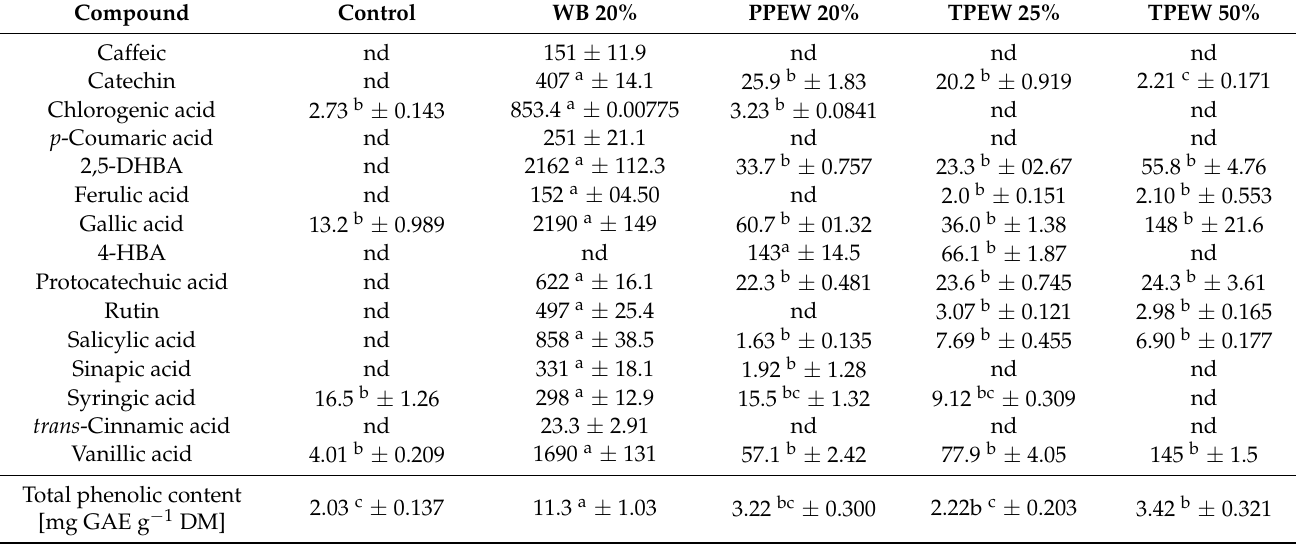
Table 3. Content of phenolic compounds ( µ g g − 1 DM) in fruit bodies of Pleurotus citrinopileatus growing at substrates enriched with different